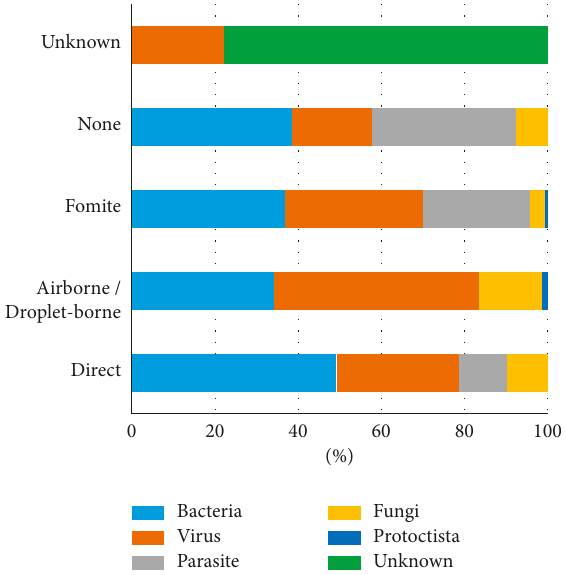
Figure 7: The transmission routes of the infectious disease pathogens in Ghana. This indicates the transmission routes and the pathogens associated with them in